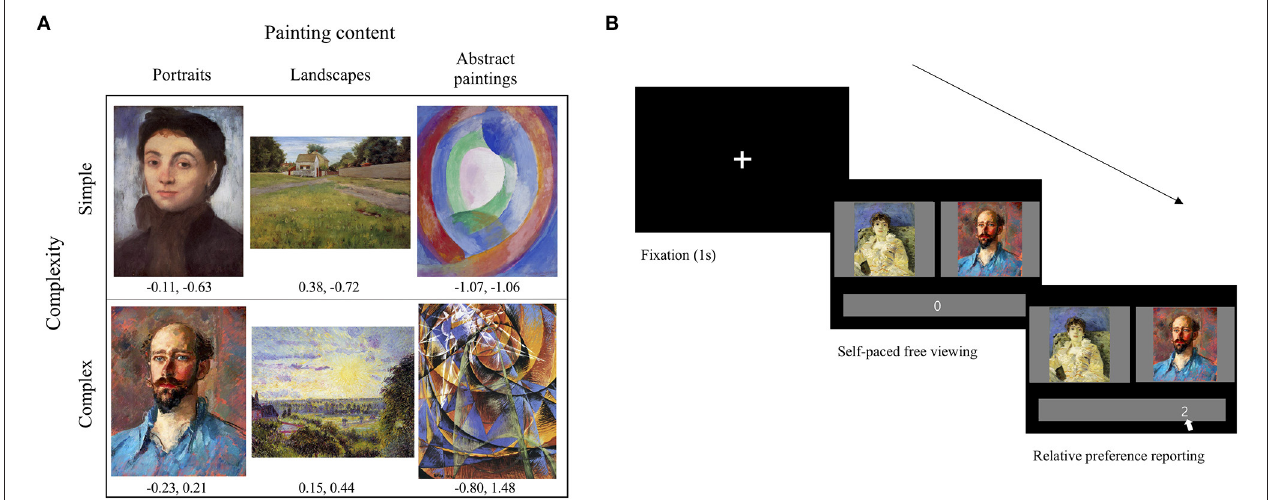
FIGURE 1 | Stimuli and trial sequence. (A) Examples of images that were used in the experiments. All the paintings that are shown in this figure are copyright-free images that were sourced from WikiArt 1 . The values under the images are the mean raw scores of preference (left) and complexity (right) obtained from the preliminary survey. (B) An illustration of a sample experimental trial. After a fixation period of 1s, two images of paintings were presented side by side, below which a response bar was presented. Participants were instructed to indicate which of the two paintings they preferred with their degree of preference on a 7-point scale that ranged